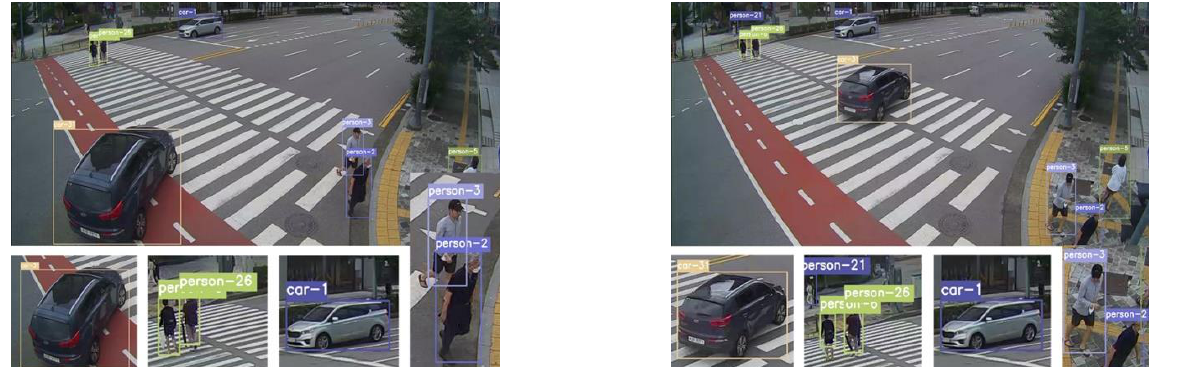
Figure 8. Results of object detection from the traffic surveillance camera.